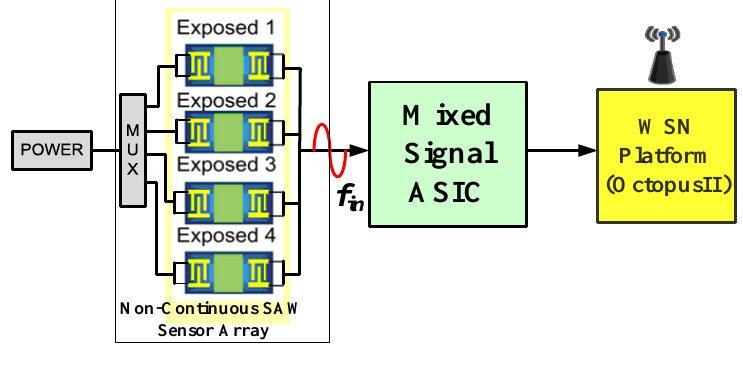
Figure 1. Block diagram of SAW sensor node.